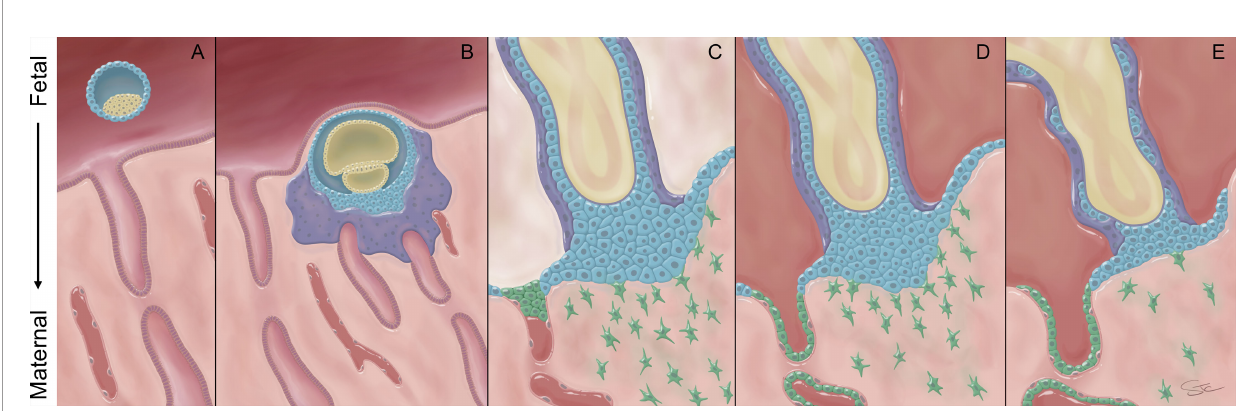
FIGURE 1 | Morphology of the human placenta across gestation. (A) Just prior to implantation, the blastocyst is comprised of an inner cell mass (yellow) that is surrounded by a single layer of trophoblast, termed the trophectoderm (blue). (B) Once the embryo contacts the maternal decidua, the trophectoderm forms a highly invasive primitive syncytium (purple). This multi-nucleated syncytium contacts maternal glands that provide histotroph to nourish the growing embryo. Beneath the primitive syncytium, the villous cytotrophoblast cells (VCT; blue) proliferate and eventually break through the primitive syncytium to generate tree-like primary and, ultimately, more mature villous structures. (C) Villi that reach and anchor to the maternal decidua are the source of the cytotrophoblast cells that will form the cytotrophoblastic shell (blue). Extravillous cytotrophoblast cells (EVT, green) invade into the decidua and interact with maternal cells and plug the maternal spiral arteries to prevent onset of maternal blood fl ow into the space between the placental villi, called the intervillous space. (D) Near the end of the fi rst trimester, the EVT plugs dissolve and the EVT continue to remodel the spiral arteries to establish robust maternal blood fl ow into the intervillous space. (E) By the end of pregnancy, the VCT layer becomes sparse and the cytotrophoblast shell